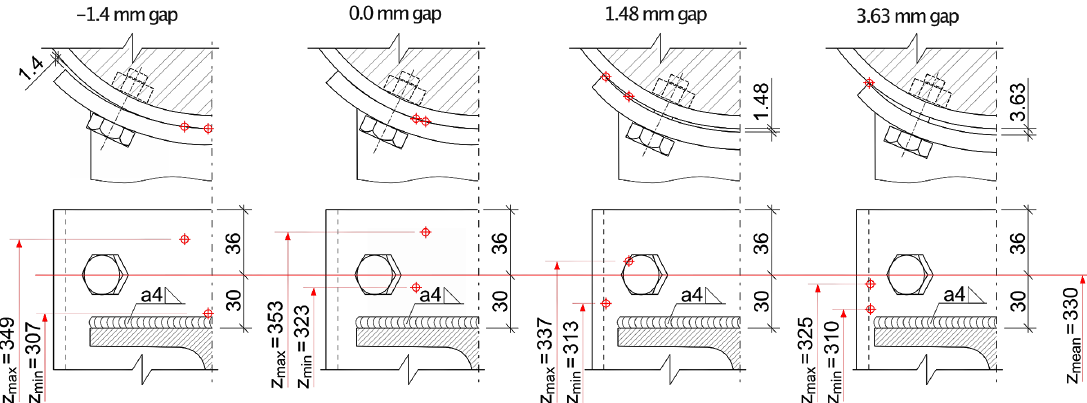
Figure 15. Position of the centre of compression (Mudrov et al., 2021) a)